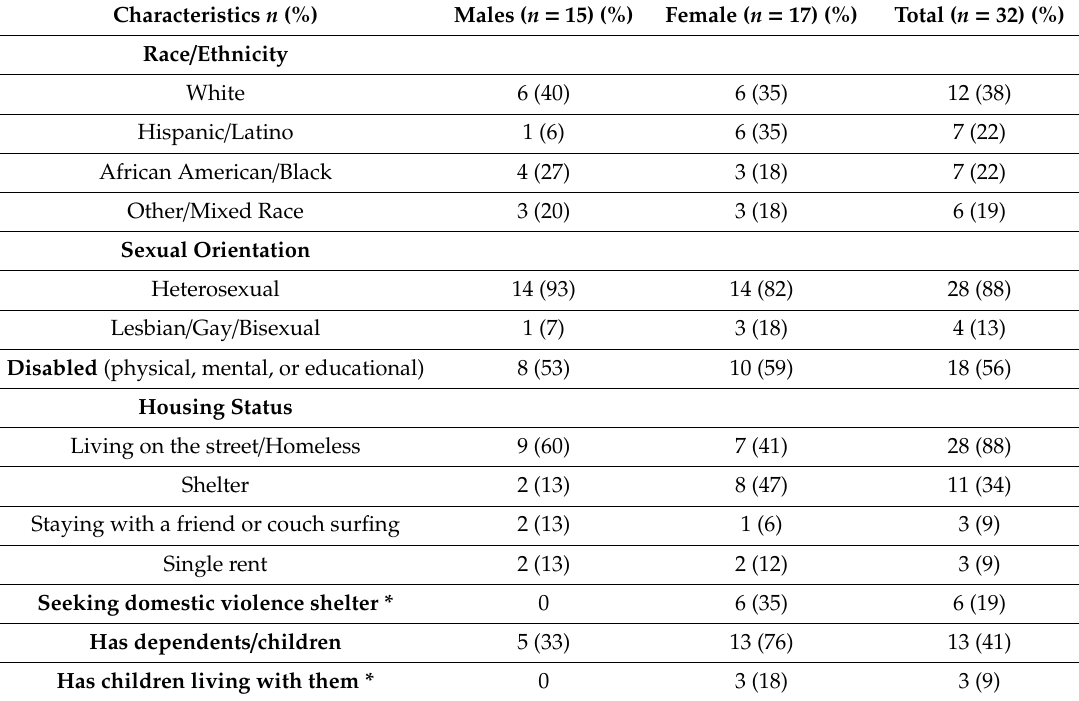
Table 1. Socio-demographic characteristics, unstably housed study participants qualitatively interviewed at a large urban library in southern California ( n = 32), derived from socio-demographic surveys.